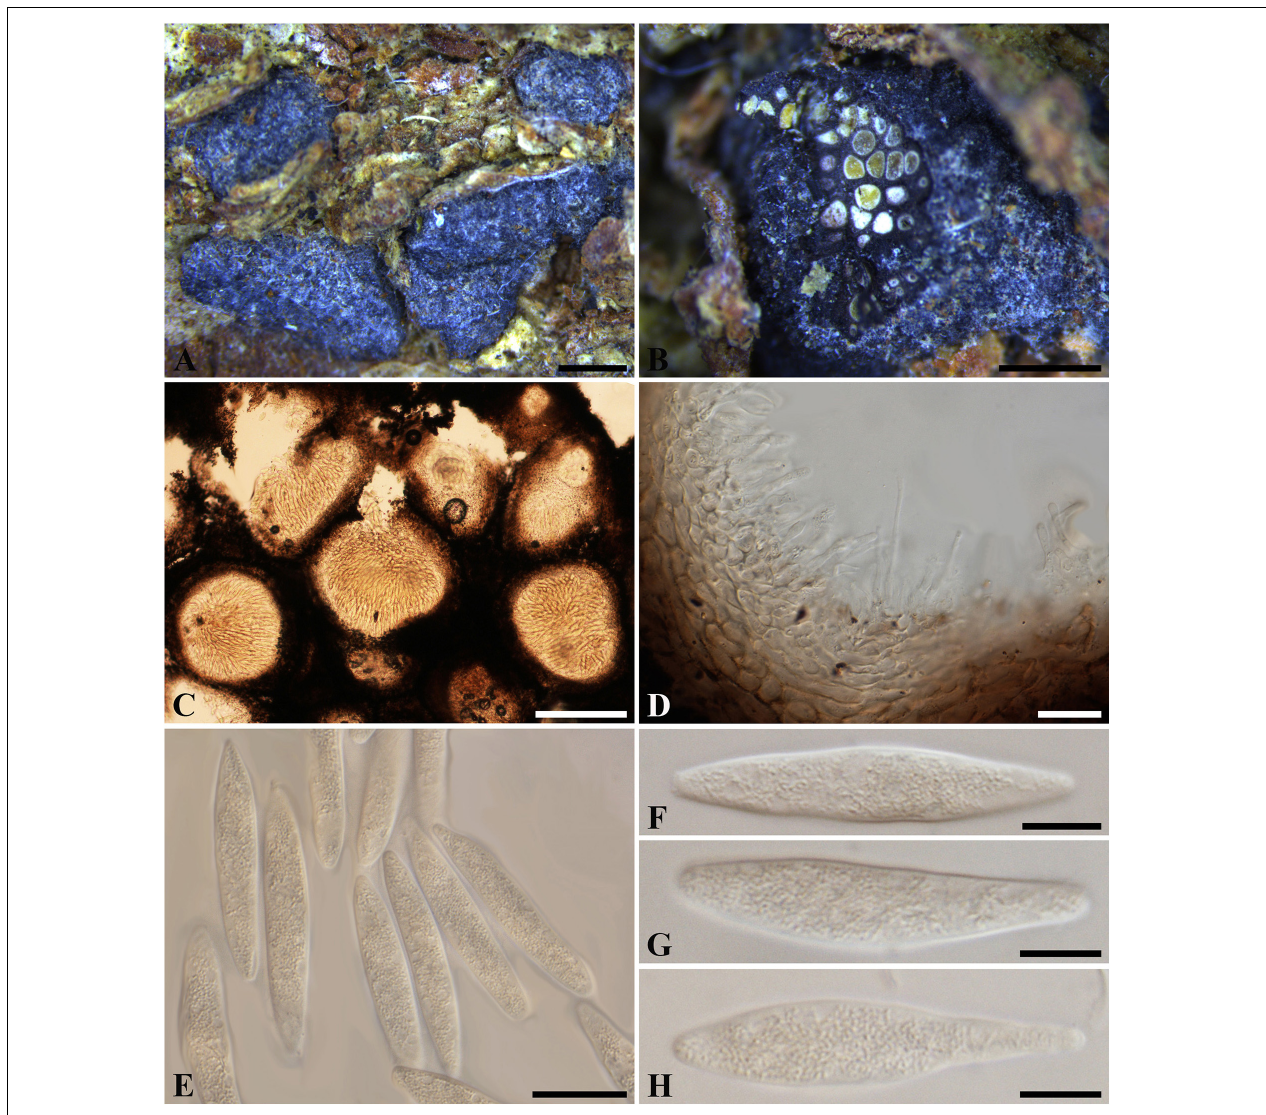
FIGURE 1 | Botryosphaeria aterrima (G 00266252, holotype ). (A) Dense botryose cluster of conidiomata erumpent through the bark. (B) Transverse section of the conidiomata. (C) Longitudinal section of conidiomata. (D) Conidiogenous cells and paraphyses. (E–H) Conidia. Scale bars: (A) = 5 mm, (B) = 1 mm, (C) = 200 µ m, (D,E) = 20 µ m, (F–H) = 10 µ